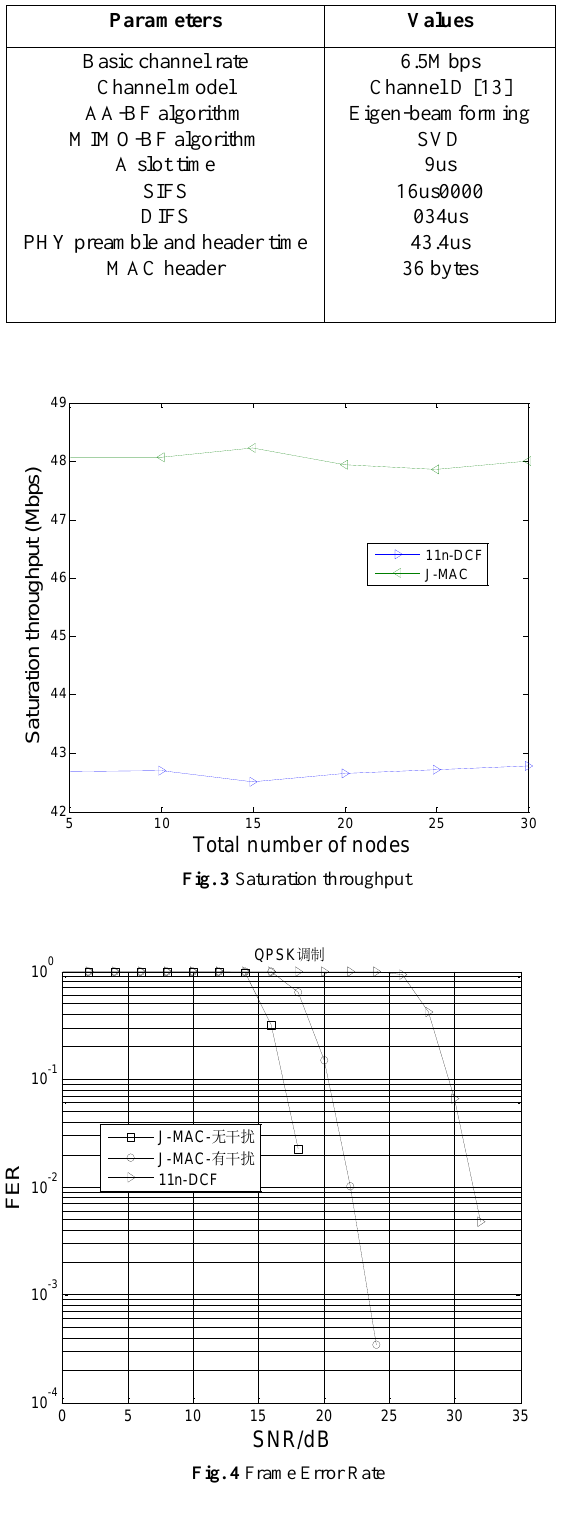
Table I SIMULATION